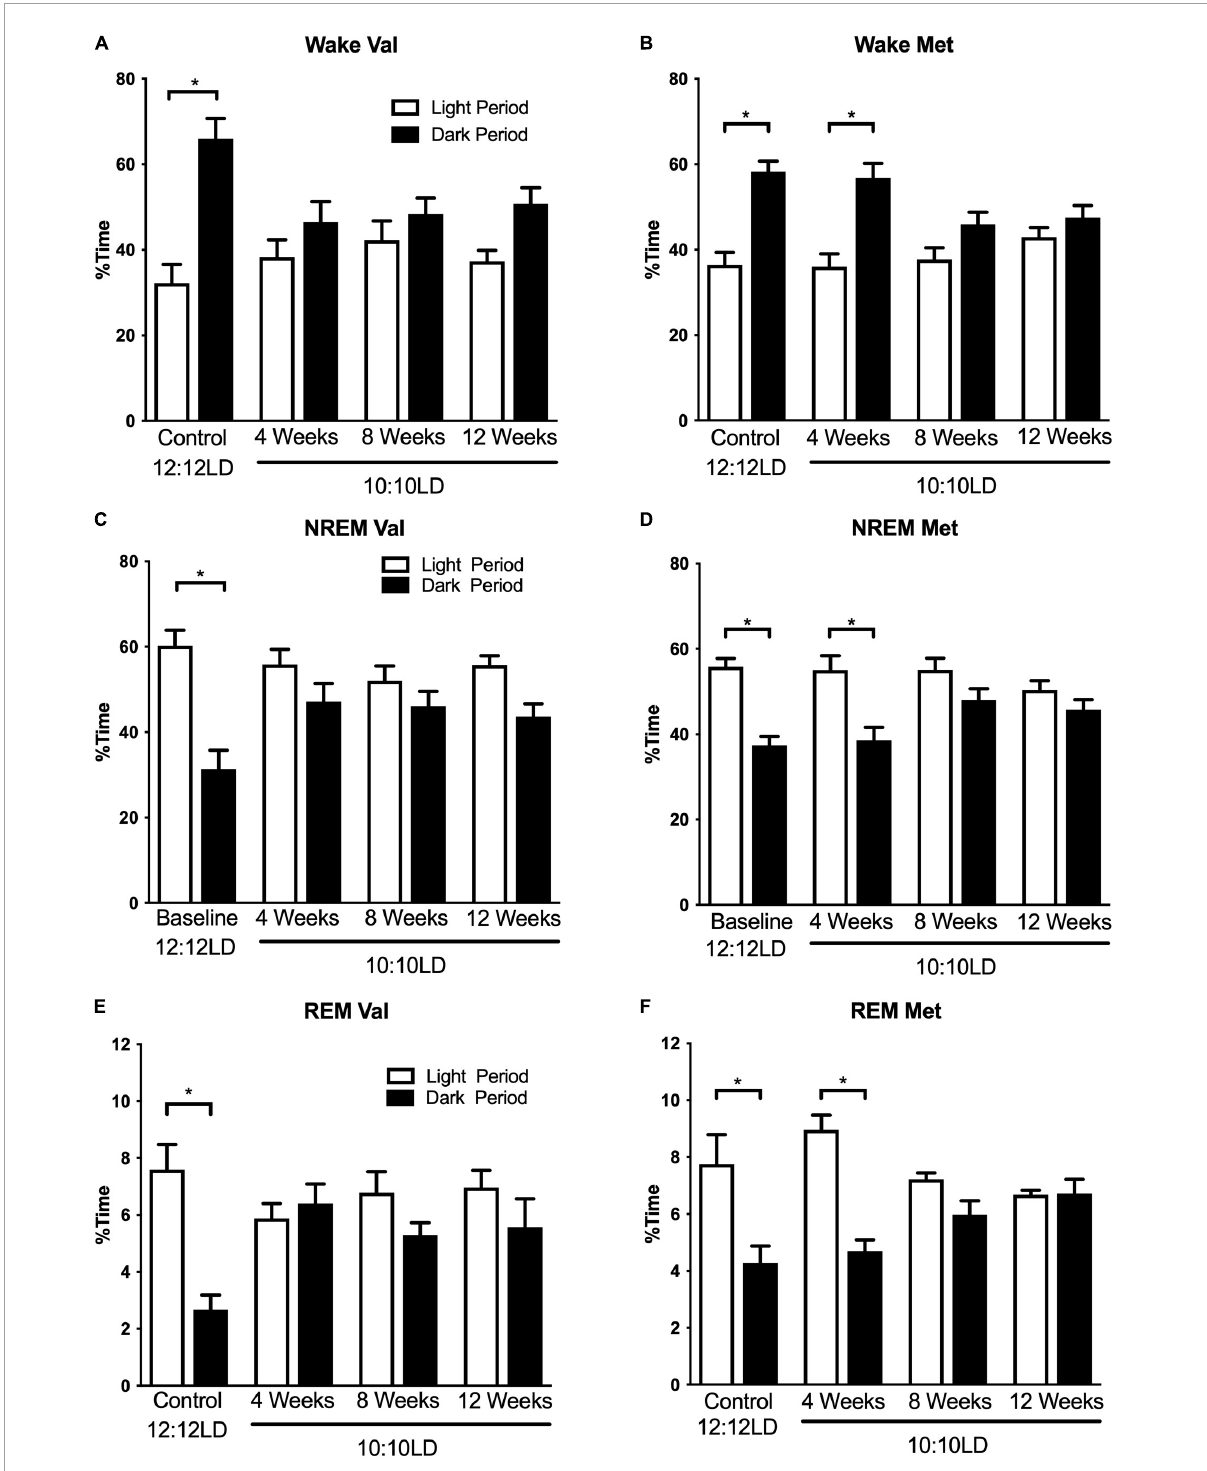
FIGURE1 Environmental circadian desynchronization alters distribution of wake and sleep across the light and dark period differently in Val and Met animals. Graphs demonstrate changes in niche appropriate sleep timing under baseline and ECD conditions. In baseline conditions, Val mice (A) show a significant difference in wake time between the light (white bars) and dark (black bars) phase. However, these differences were no longer significant following 20, 40, and 60 days of LD10:10 ECD. Met mice (B) show a similar light/dark difference during the baseline recording. Following 20 days of LD10:10 ECD, light light/dark difference wake time is maintained, but not after 40 and 60 days of LD10:10 ECD. These differences are also present during NREM sleep for the Val (C) , and Met (D) , and REM sleep (E) and (F) . Two-way ANOVA; * p <